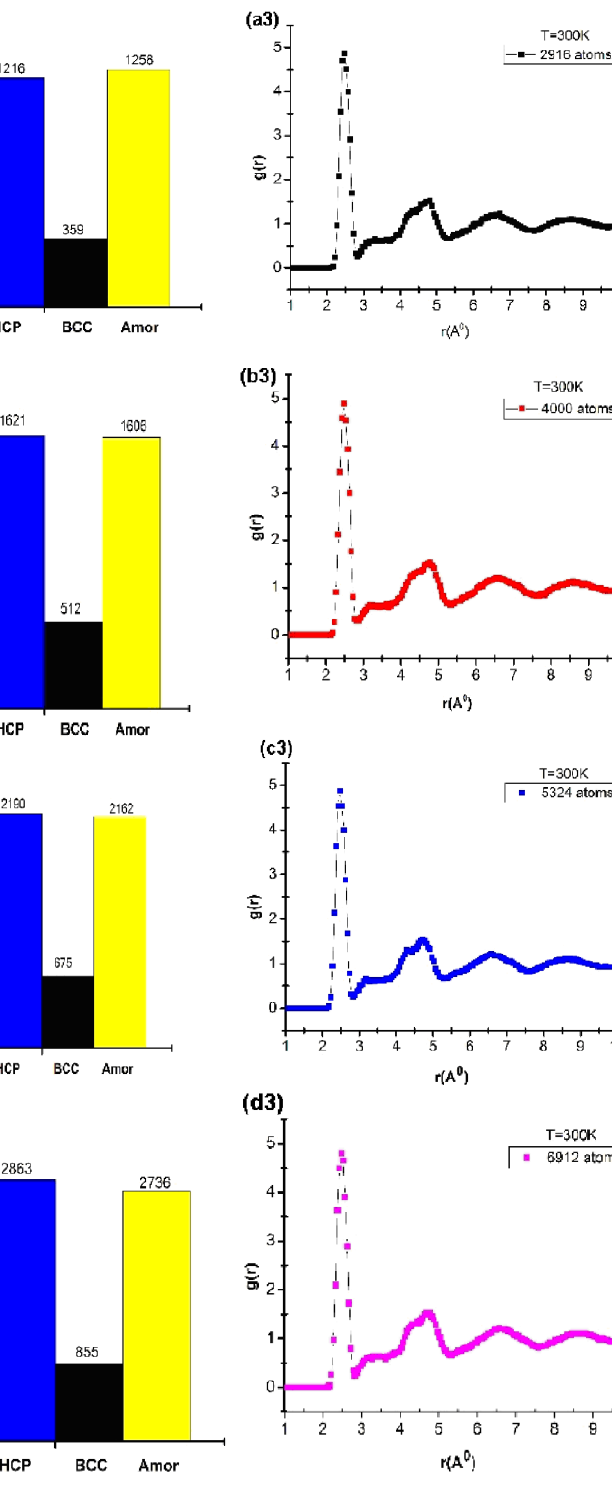
Figure 2. Structure shape ( a1 , b1 , c1 , d1 ), number of structural units ( a2 , b2 , c2 , d2 ), and radial distribution function ( a3 , b3 , c3 , d3 ) of cubic Cu with different atom numbers .